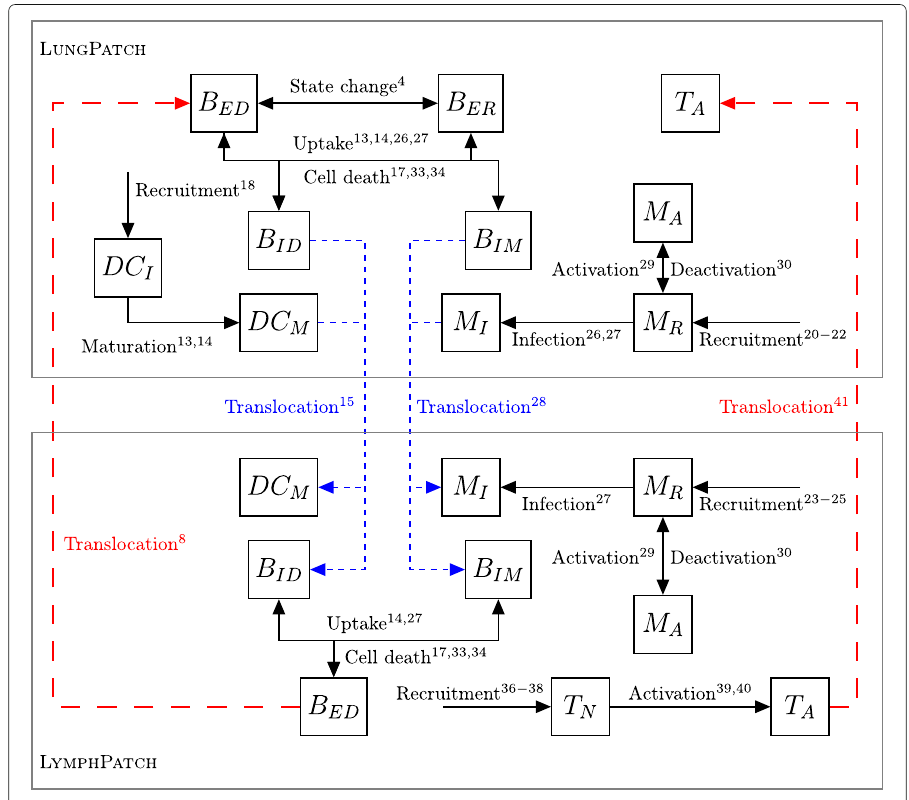
Fig. 3 Schematic for the dynamics of TBMetapopPy using topology A. Arrows indicate possible transition routes of members between compartments. Long-dash red arrows indicate translocation across a BloodEdge from lymphatics to the lung, short-dashed blue arrows indicate translocation across a LymphEdge, from the lung to the lymphatics. Numbers for each transition relate to the events that define the transition, as described in the Additional file